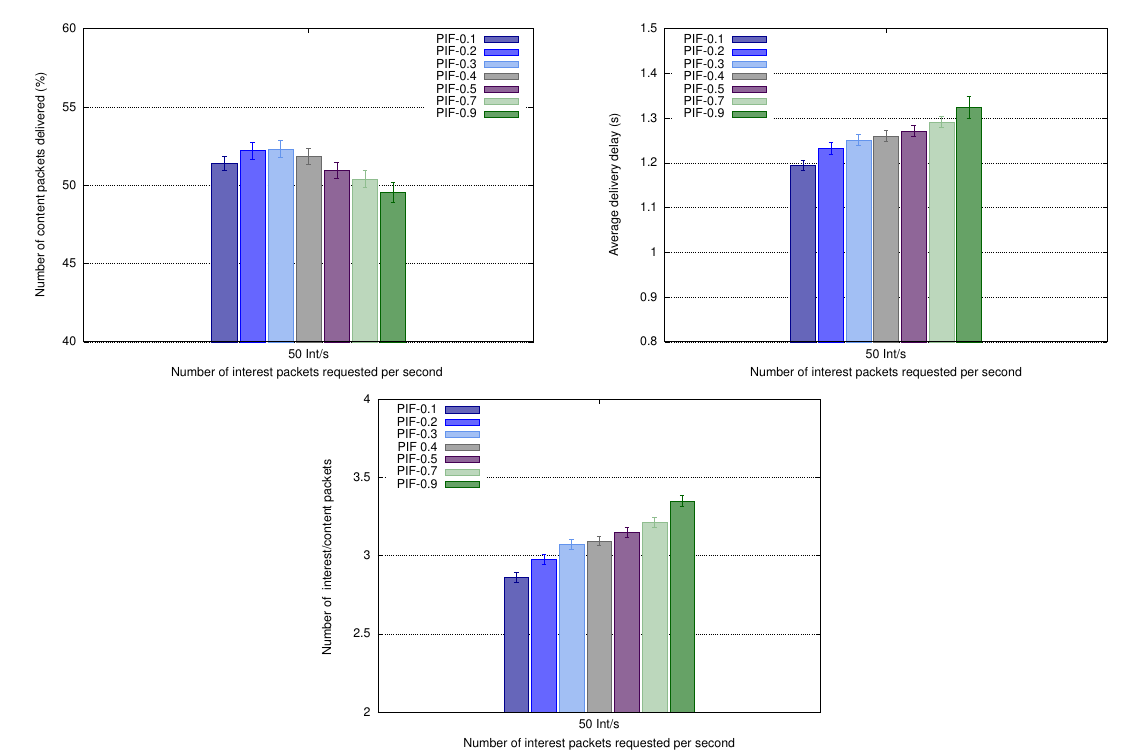
Figure 7. Content packets delivered, average delivery delay, and overhead for 30 consumers requesting popular contents with PIF considering different interest forwarding